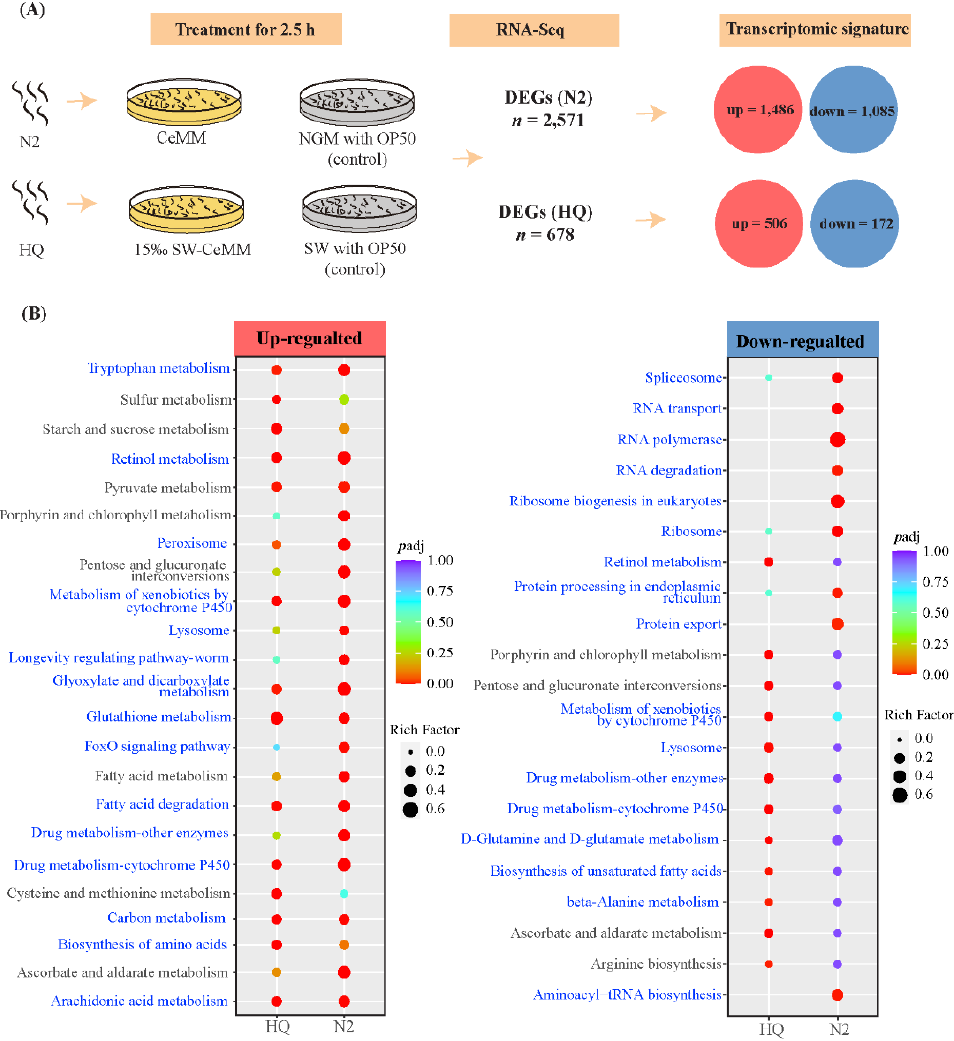
Figure 2. The transcriptomic signature of C. elegans and L. marina . ( A ) Experimental design of this study and the resulting transcriptomic signature of worms. Differentially expressed genes (DEGs, |Log2Fold change| > 1; DESeq2 p adj < 0.01) were determined for each condition. ( B ) KEGG enrichment analysis for DEGs. ‘HQ’ and ‘N2 ′ represent L. marina and C. elegans , respectively. ‘Up-regulation’ indicates increased gene expression in the CeMM diet compared to the OP50 diet. ‘Down- regulation’ indicates decreased gene expression in the CeMM diet compared to the OP50 diet. The color change from red to green represents the significance of the enrichment. We focused on the pathway of blue font enrichment. The Rich Factor was defined as the ratio between the number of differentially expressed genes and the number of all genes in the KEGG pathway.